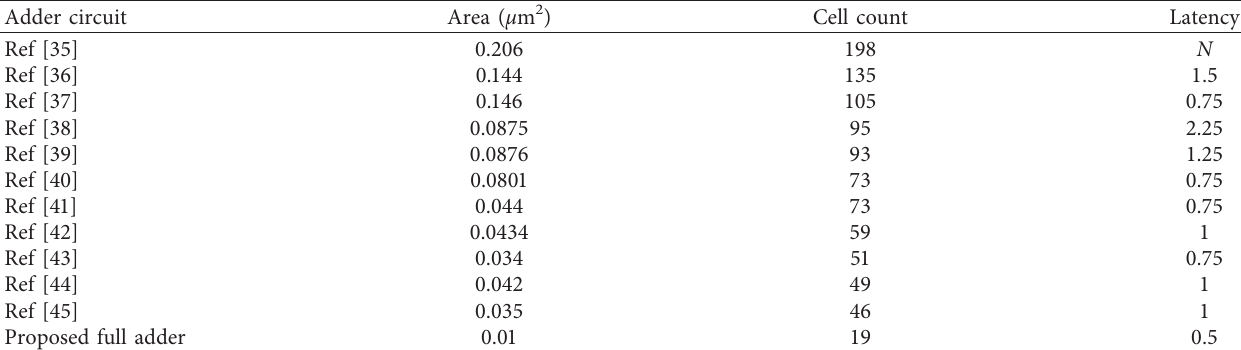
Table 2: Full adder comparison.